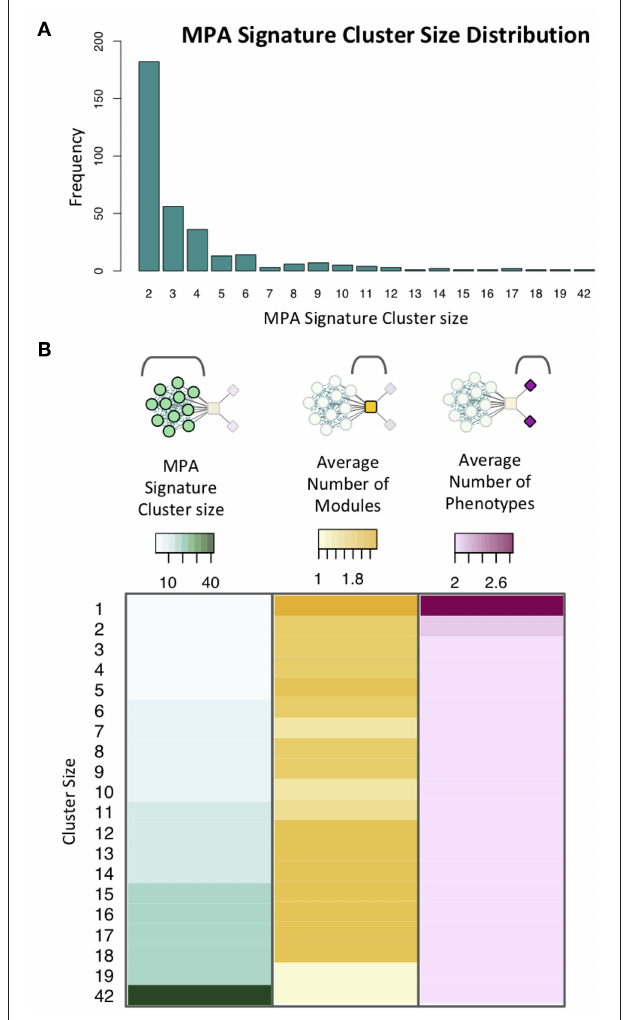
FIGURE 13 | Signature clusters in powerset space. (A) Cluster size distribution for signature clusters containing ≥ 2 genes. (B) Heatmap showing cluster size (green), average number of modules associated with genes of a given cluster size (yellow) and average number of phenotypes associated with genes in clusters of a given size